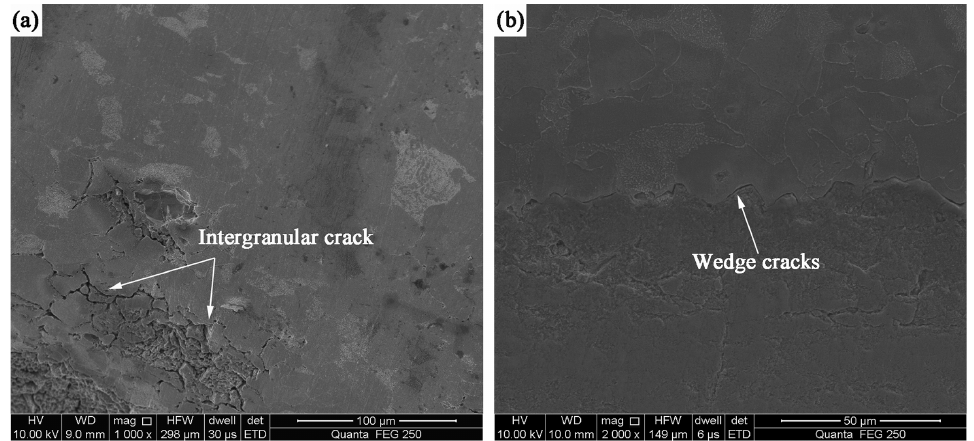
Figure 9: SEM micrograph of cracks and defected structures between the corrosive/oxide layer and unaffected zone of the (a) corrosive specimen and (b) bare specimen at 973.15K/100MPa.